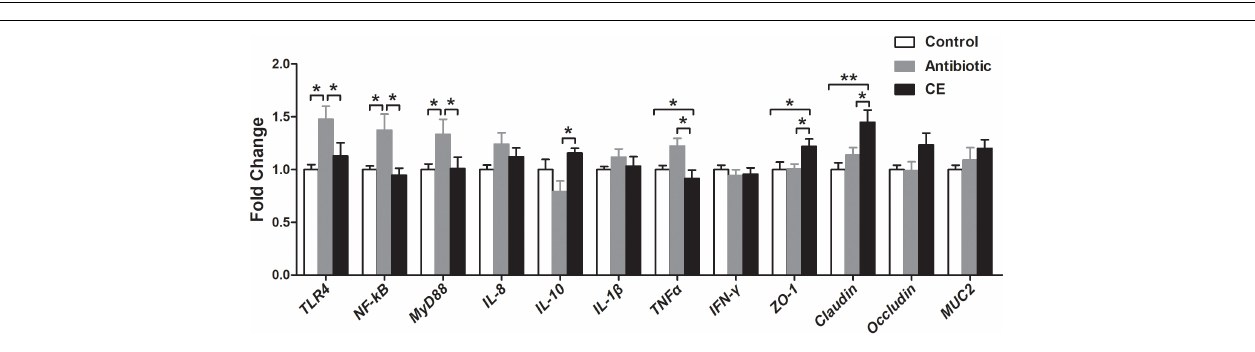
FIGURE 7 | Effect of the dietary supplementation with citrus extract on the relative mRNA expression of genes related to TLR signaling pathway, cytokines, and barrier function in the ileal tissue of Chinese yellow-feathered broilers. Asterisks indicate statistical differences between different groups (one-way ANOVA with